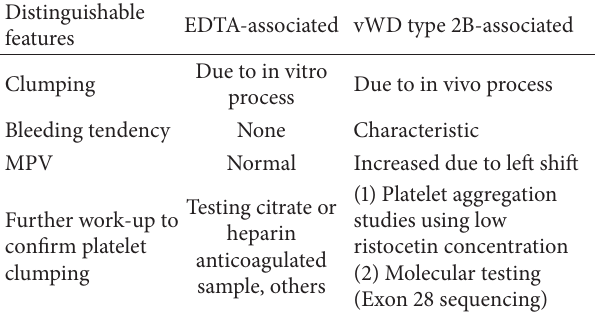
Table 2: Comparison between EDTA-associated and vWD type 2B- associated platelet